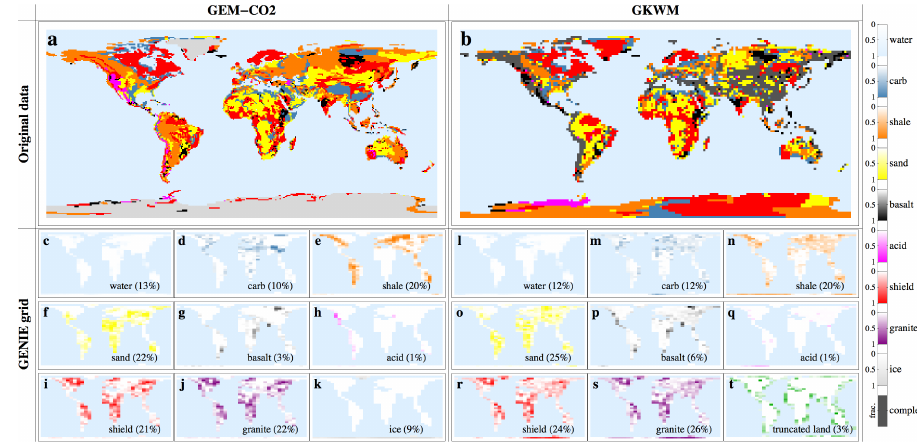
Fig. 17. Distribution of lithologies from GEM-CO2 (Amiotte-Suchet et al., 2003) (a, c–k) and GKWM (Gibbs and Kump, 1994) (b, l–t) ; original source data is shown in the large panels ( a, b ; GEM-CO2 at 1 ◦ resolution and GKWM at 2 ◦ resolution); data interpolated onto the GENIE grid (36 × 36 equal area longitude-sine(latitude) cells) is shown in the smaller panels (c–t) . Rock types are colour coded as in (Amiotte-Suchet et al., 2003). For the GENIE grid, each rock type fills a certain fraction of each cell; increasing fractions from 0 to 1 are shown by fading in colour from white (0) to full colour (1). See text for definition of “complex”.